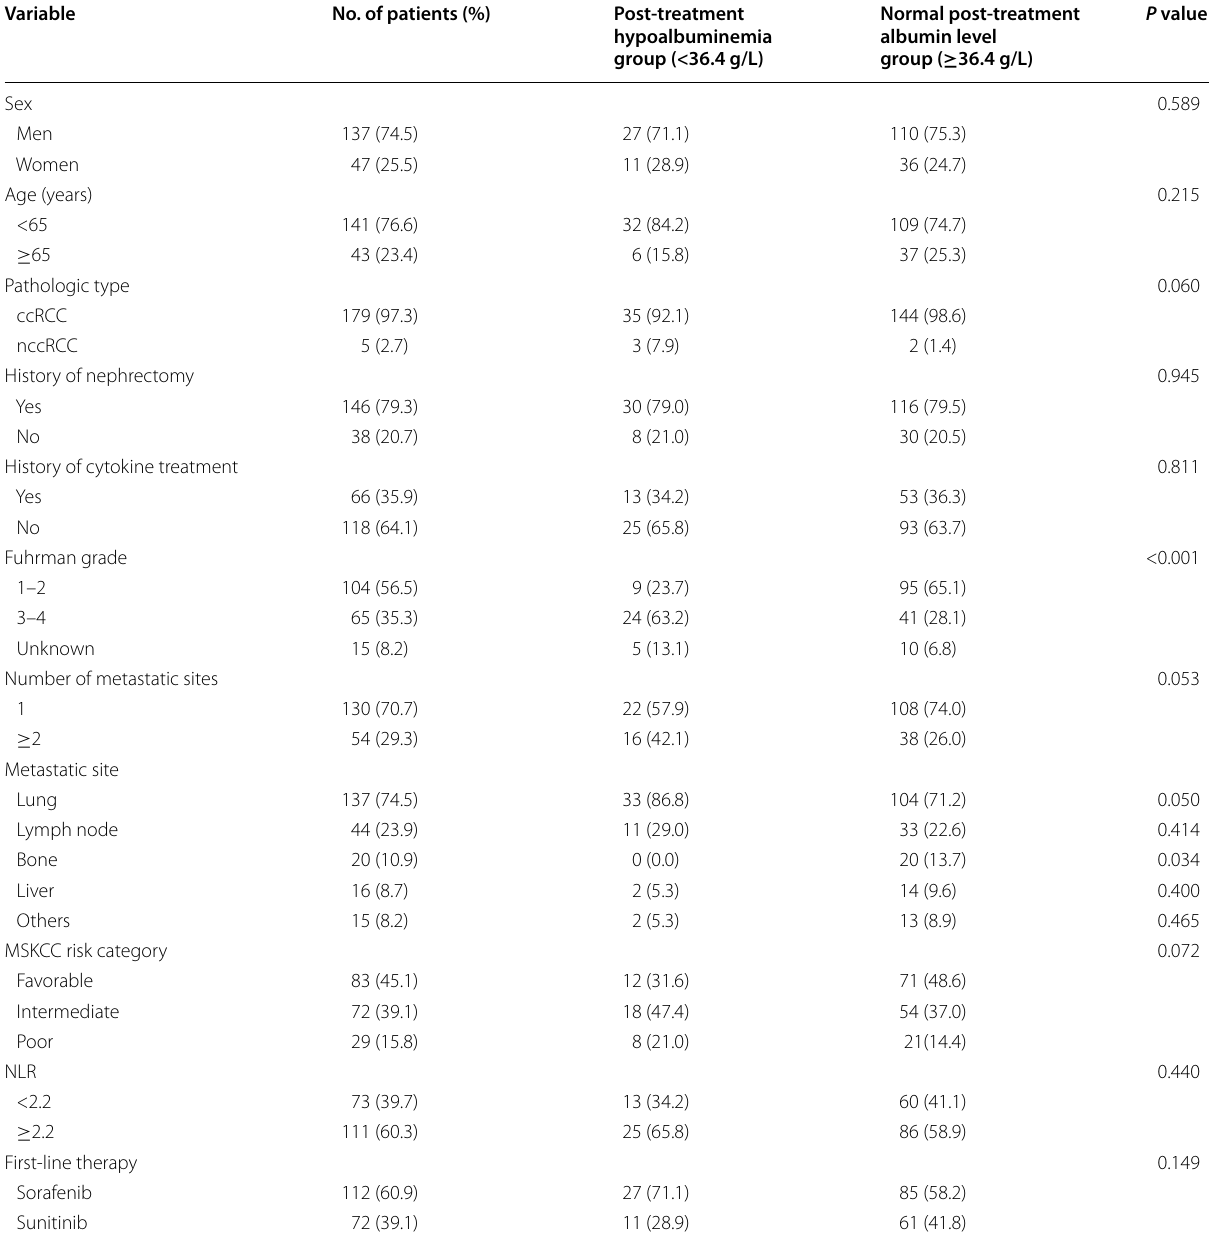
Table 1 The baseline and clinicopathologic characteristics of 184 patients with metastatic renal cell